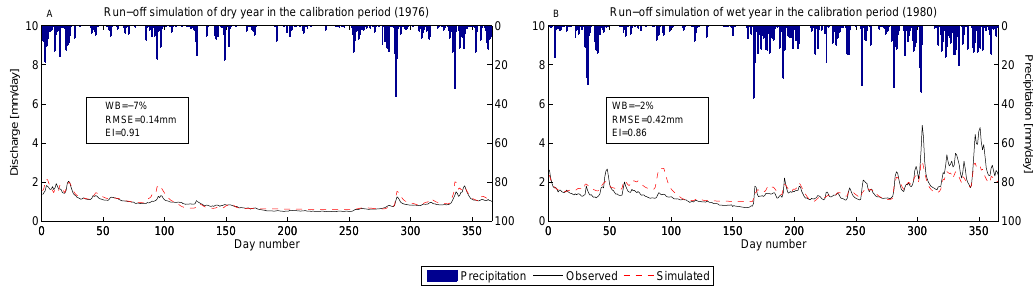
Fig. 6. Hydrograph for two years within the calibration period with rainfall input. (A) The driest year; (B) the wettest year.